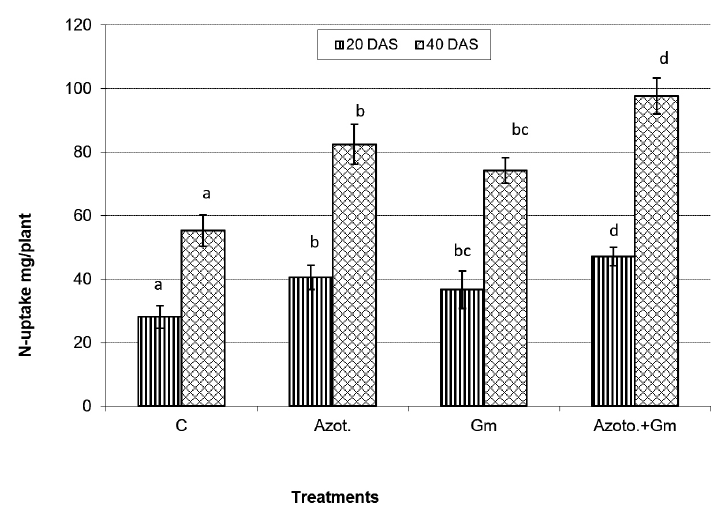
Fig. 2. Nitrogen uptake of onion plants as influenced by inoculation with Glomus moseae (Gm) and Azotobacter chroococcum (Azoto.), 20 and 40 days after planting Table 4. Mycorrhizal spores in soil and percentage mycorrhizal infection of onion roots as influenced by inoculation with Glomus moseae and Azotobacter chroococcum , 20 and 40 days after planting (DAS) Treatments Mycorrhizal